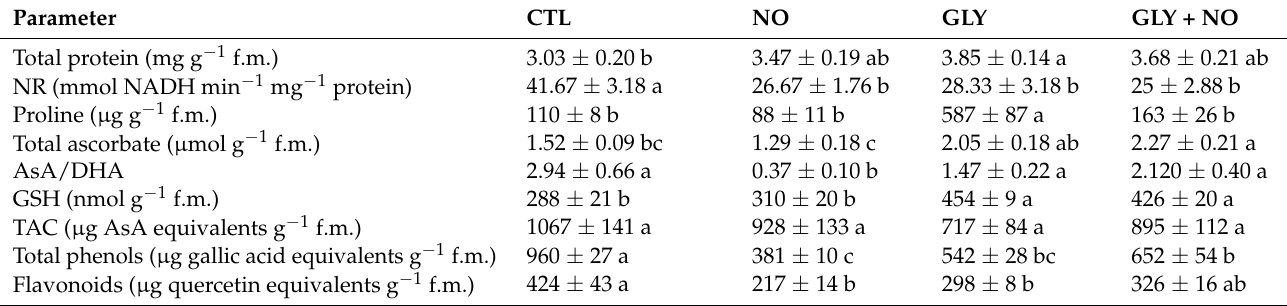
Table 1. Biochemical parameters (total protein, nitrate reductase (NR) activity, proline, total ascorbate, ascor- bate:dehydroascorbate (AsA/DHA) ratio, glutathione (GSH), total antioxidant capacity (TAC), total phenols and flavonoids) of shoots of Solanum lycopersicum L. cv. Micro-Tom grown for 28 days in an artificial soil contaminated by GLY (10 mg kg − 1 ) and/or foliar sprayed with SNP (200 µ M). CTL—control plants, grown in the absence of GLY and foliar sprayed with dH 2 O once a week; NO—plants grown in the absence of GLY and foliar sprayed with SNP once a week; GLY—plants grown in the presence of GLY; GLY + NO—plants grown in the presence of GLY and weekly sprayed with SNP. Results are presented as mean ± standard deviation (SD) and result from the evaluation of at least three experimental replicates ( n ≥ 3). Different letters indicate significant differences between groups (CTL, NO, GLY and GLY + NO) at p ≤ 0.05, according to the one-way ANOVA followed by Tukey’s post hoc test.